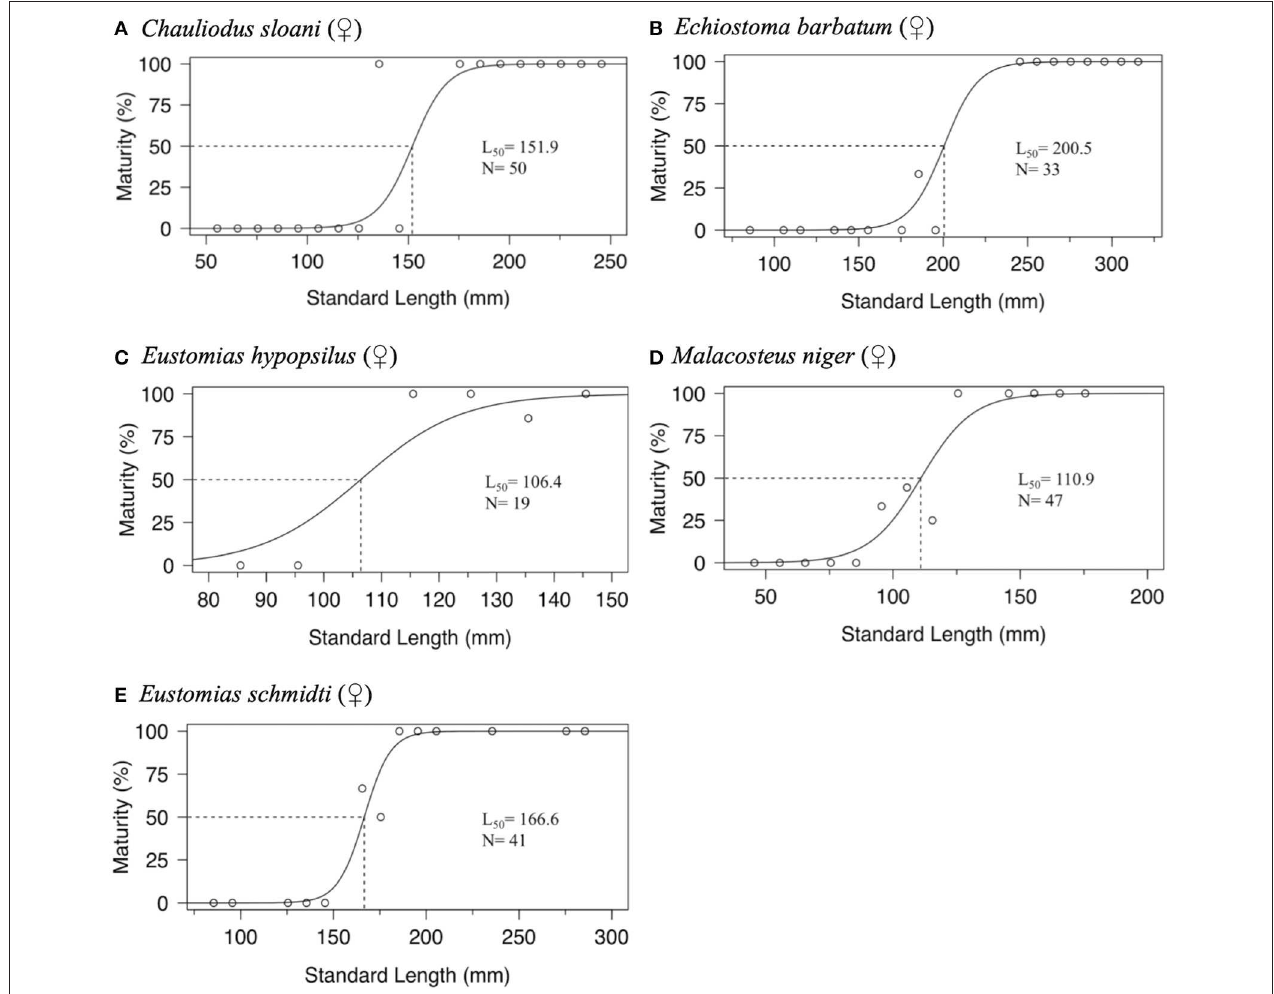
FIGURE 4 | Binomial regression of size at maturity of: (A) female Chauliodus sloani , (B) female Echiostoma barbatum, (C) female Eustomias hypopsilus , (D) female Malacosteus niger , and (E) female Eustomias schmidti . Dotted lines indicate standard length at median sexual maturity (L 50 ). N = sample size.